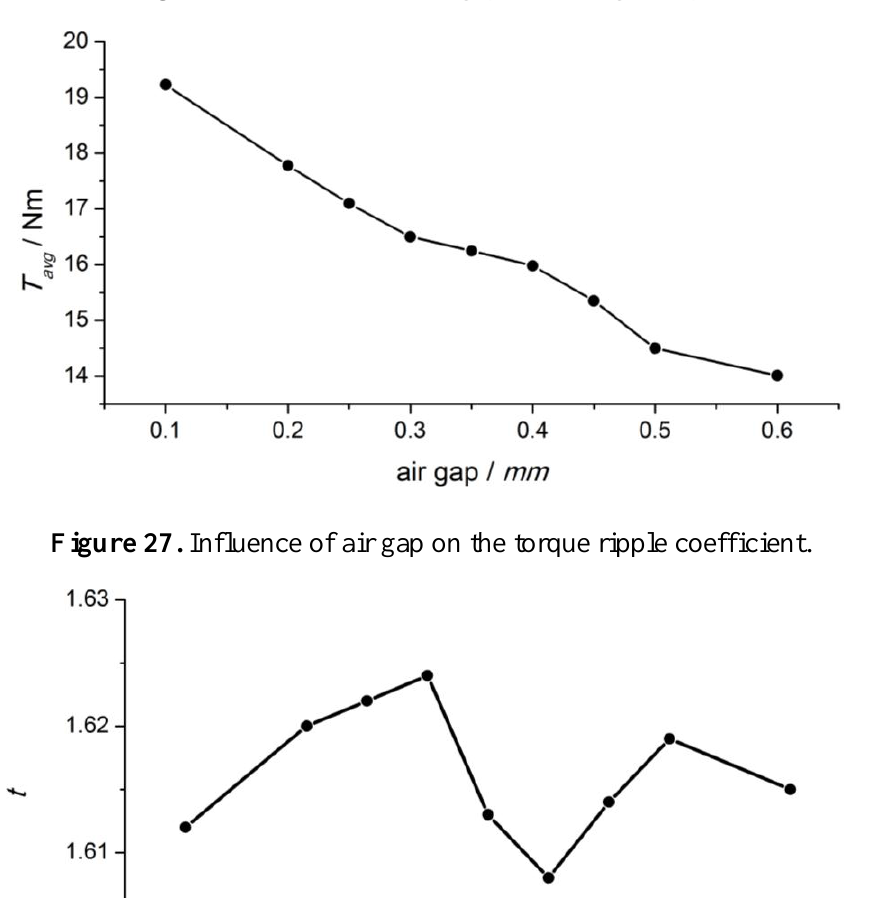
Figure 26. Influence of air gap on average torque.